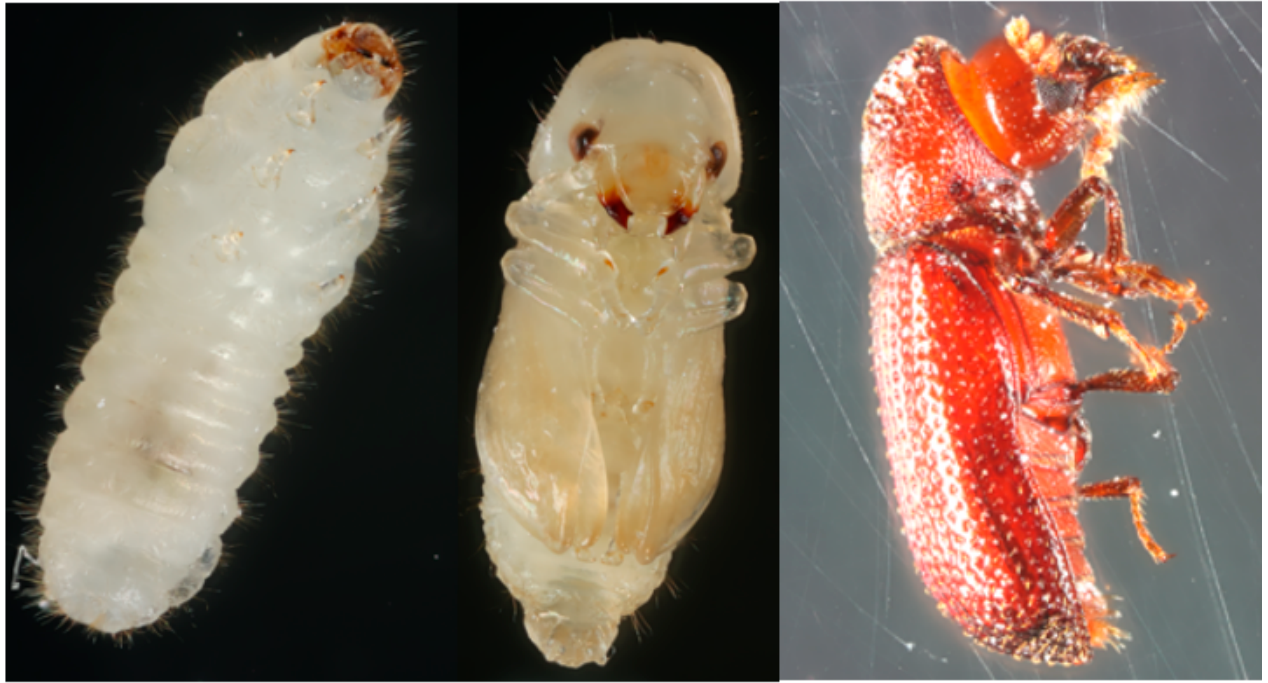
Figure 1. Photographs of different life stages of R. dominica. Left, larva; middle, pupa, right, adult.